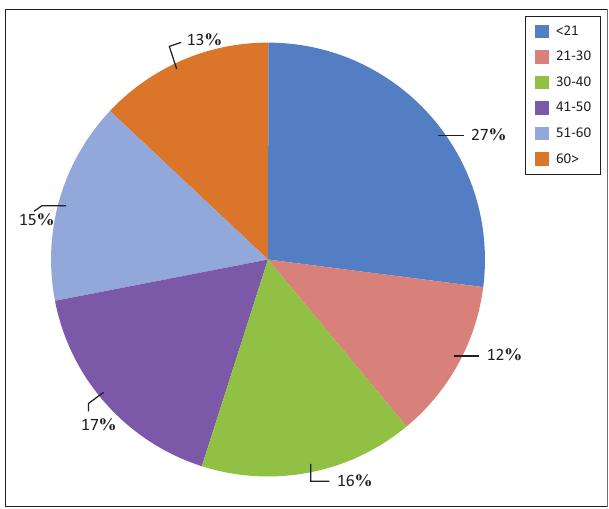
FIGURE 2: Age distribution of respondents.